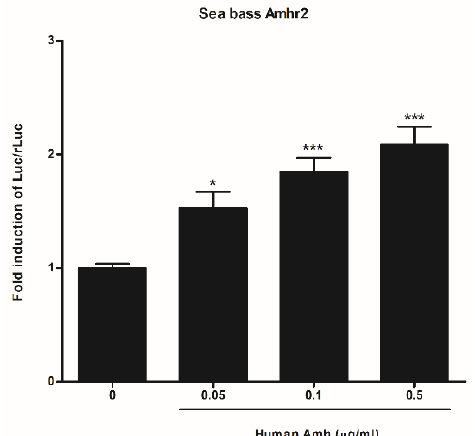
Figure 3. Human AMH induces sea bass Amhr2-dependent BRE-luc reporter activity. COS-7 cells were transiently transfected with sea bass Amhr2, along with the BRE-Luc reporter and pRL-TK plasmids. The cells were incubated with three different concentrations of hAMH for 24 h in a 1% FBS culture medium. Firefly luciferase activities were normalized to pRL-TK Renilla luciferase. The results shown are the fold induction of corrected luciferase activity (expressed as RLUs) over the values of control cells treated with the hAMH diluent BSA-HCl in a 1% FBS culture medium. Data represent the mean ± SEM of three independent experiments, carried out in triplicate for each condition, and were analyzed by ANOVA followed by Tukey’s significant interaction test. Bars with asterisks are significantly different (* p < 0.05; *** p <